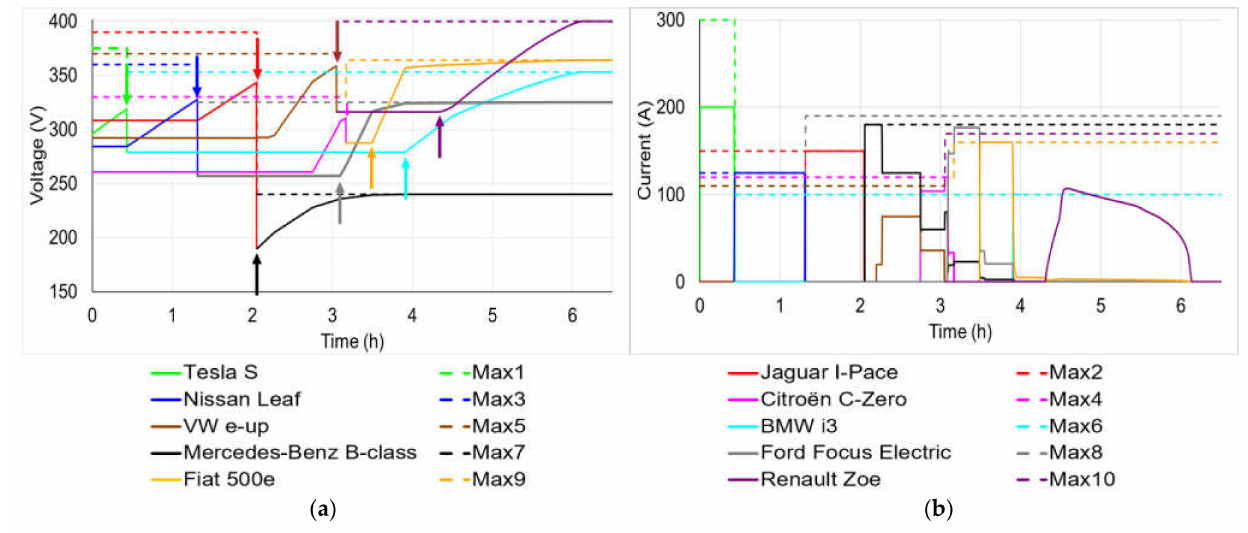
Figure 3. Battery terminal voltage ( a ) and current ( b ) of the EVs during partial charging. Here, the Tesla S (green profile of Figure 3), Nissan Leaf (blue profile), Jaguar I-Pace (red profile), VW e-up (brown profile) and Citroën C-Zero (magenta profile) occupy parking spaces 1, 2, 3, 4 and 5 respectively. At t = 0, the Tesla S begins to charge using the maximum available charging current of 200 A. At 0.43 h, its charge reaches 85% and departs from the main car park (Figure 3, green arrow). This is indicated by the level of its charging current reducing to zero, Figure 3B, and bay 1 becoming temporarily available. Shortly after, A BWM i3 (cyan profile) arrives and parks bay 1 at t = 0.48 h but must wait until t = 3.91 h to commence charging its battery (cyan arrow). At t = 0.43 h, the Nissan Leaf starts its battery charging process. At t = 1.31 h, its charging achieves 91% (blue arrow). It exits the main car park making bay 2 temporarily empty. A Ford Focus Electric (grey profile) arrives and uses the bay at t = 1.34 h, but it must wait until t = 3.09 h (grey arrow) to charge its battery. At t = 1.31 h, the Jaguar I-Pace begins charging. This car departs from the main car park when its charging attains 88% at t = 2.05 h (red arrow). At this stage, bay 3 becomes temporarily free. At t = 2.06 h, a Mercedes-Benz B-class Electric (black profile) enters the car park, utilizes the bay, and begins charging immediately (black arrow). The VW e-up begins to charge its battery at t = 2.21 h. At t = 3.05 h, its charging acquires 97%. It leaves the car park, leaving bay 4 temporarily unoccupied (brown arrow). At t = 3.07 h, a Renault Zoe (purple profile) arrives and takes over this space but must wait until t = 4.33 h to begin charging (purple arrow). Meanwhile, the Citroën C-Zero begins charging its battery